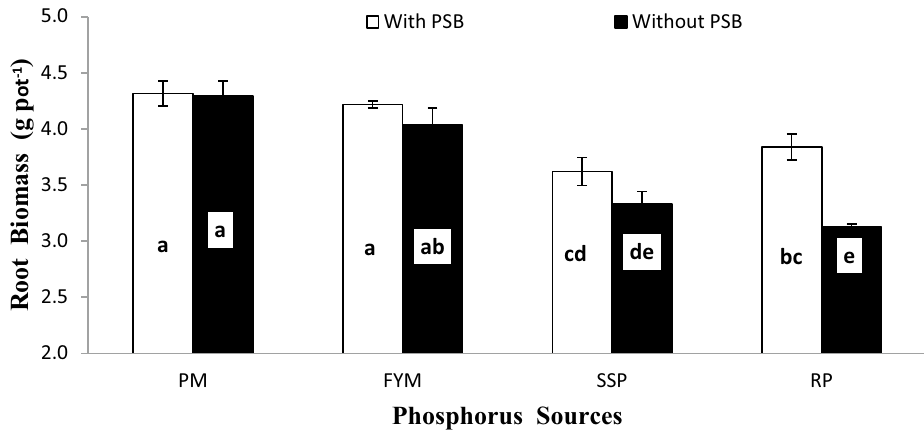
Figure 9. Interactive effect of PSB and P sources on root biomass (g). Graph bars having different letters are significantly different at α = 0.05. Errors bar represent standard error for the mean of three values.